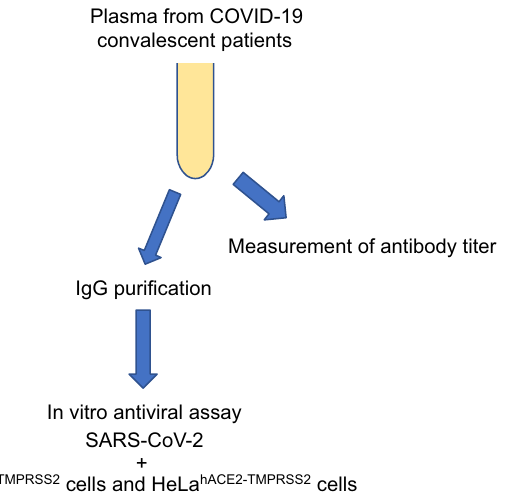
Figure 1. Schematic diagram of the IgG antibody neutralization assay of COVID-19 convalescent plasma.